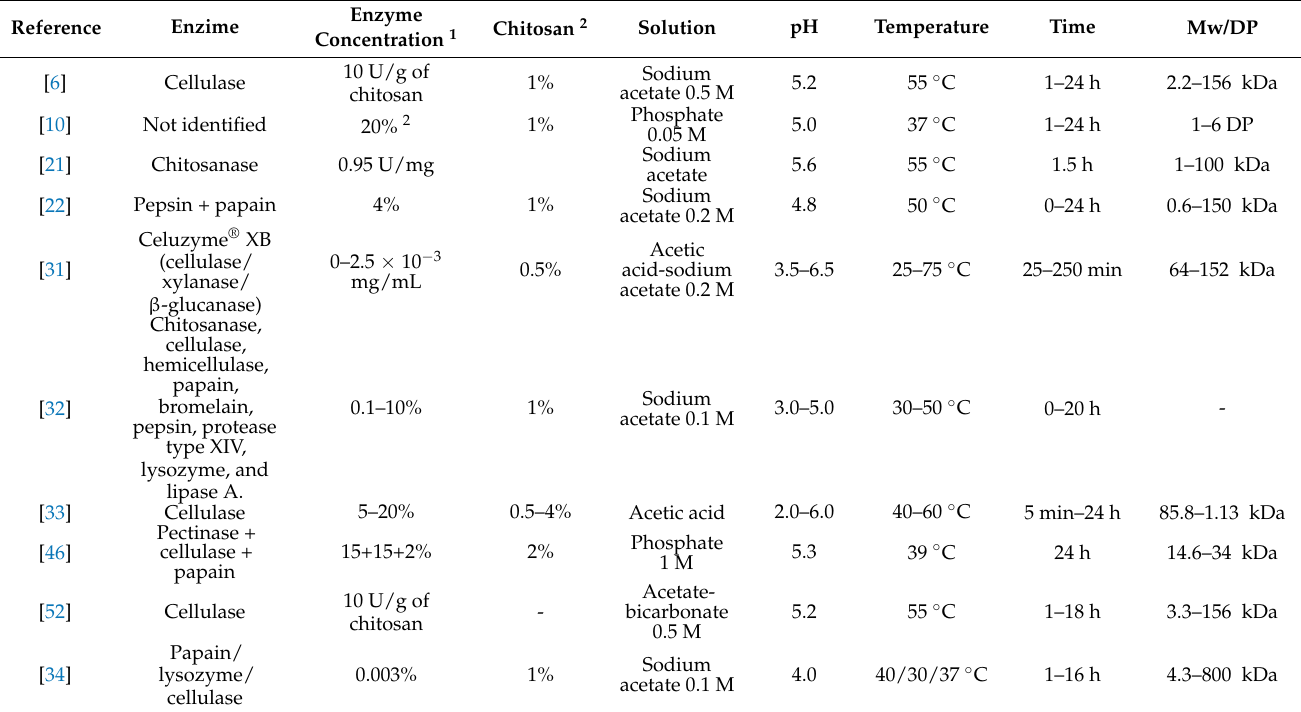
Table 5. Parameters of chitosan enzymatic